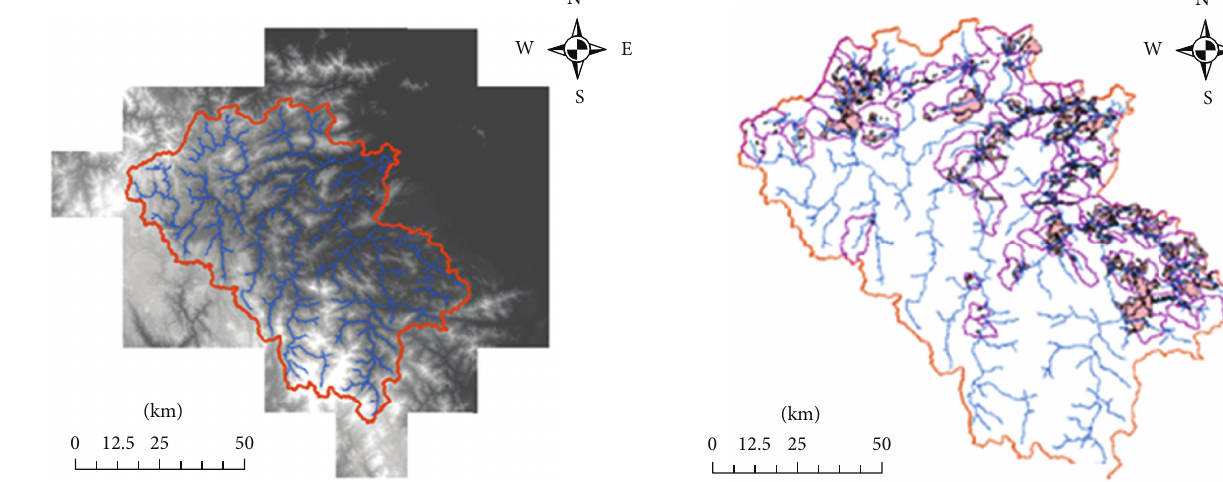
Figure 5: Rural settlement designated in watersheds.